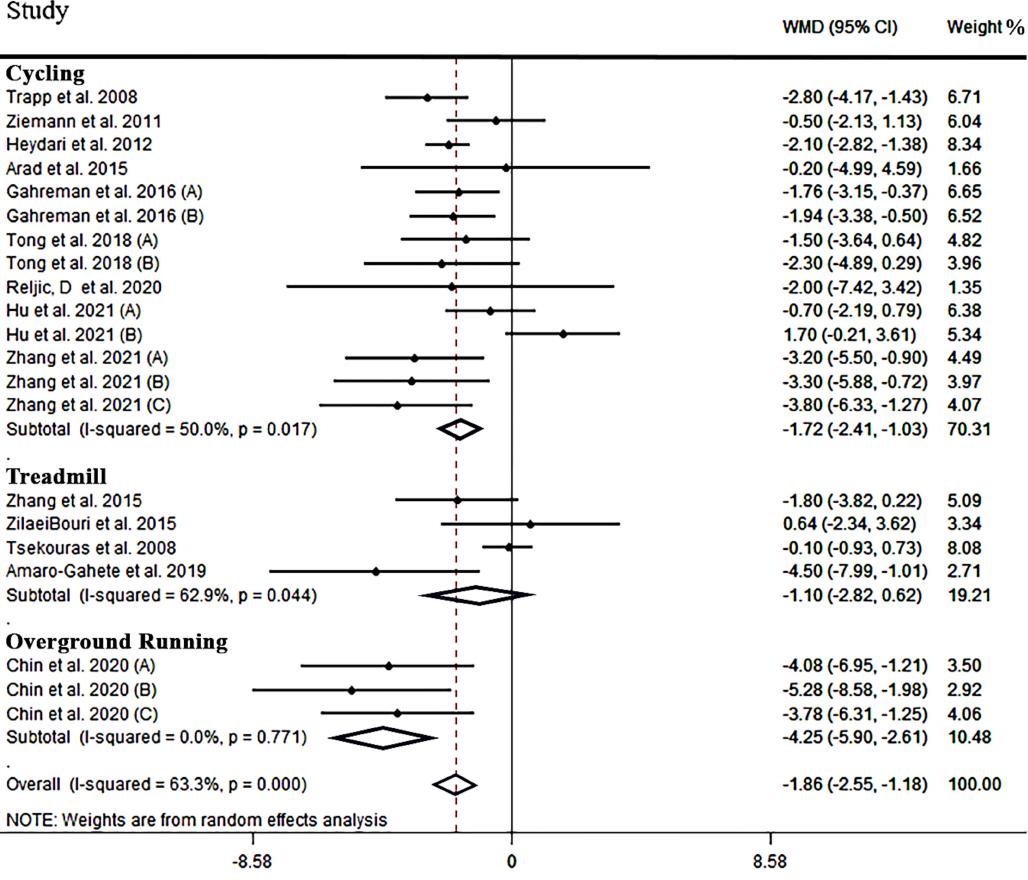
Figure 3. Forest plot detailing weighted mean difference and 95% confidence intervals (CIs) for the effect of high-intensity interval training on